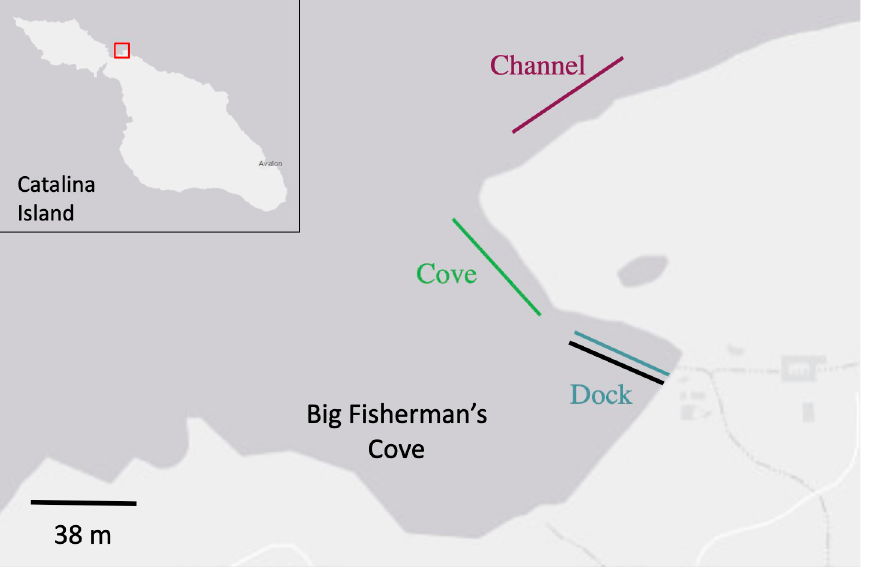
Fig 1. Map of transect locations. The location of Big Fisherman’s Cove on Catalina island and the location of the transects within the cove are displayed. The scale for the cove is in the bottom left corner. Land is represented in white and water in grey. Map services and data available from U.S. Geological Survey, National Geospatial Program.